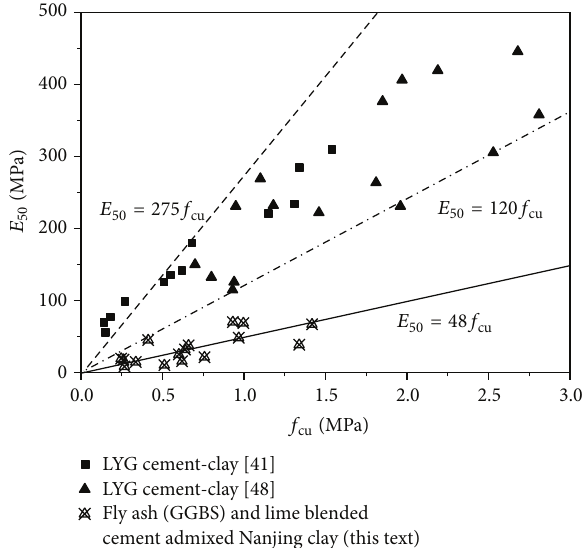
Figure 4: Correlation of modulus of elasticity with compressive strength for the different mixes